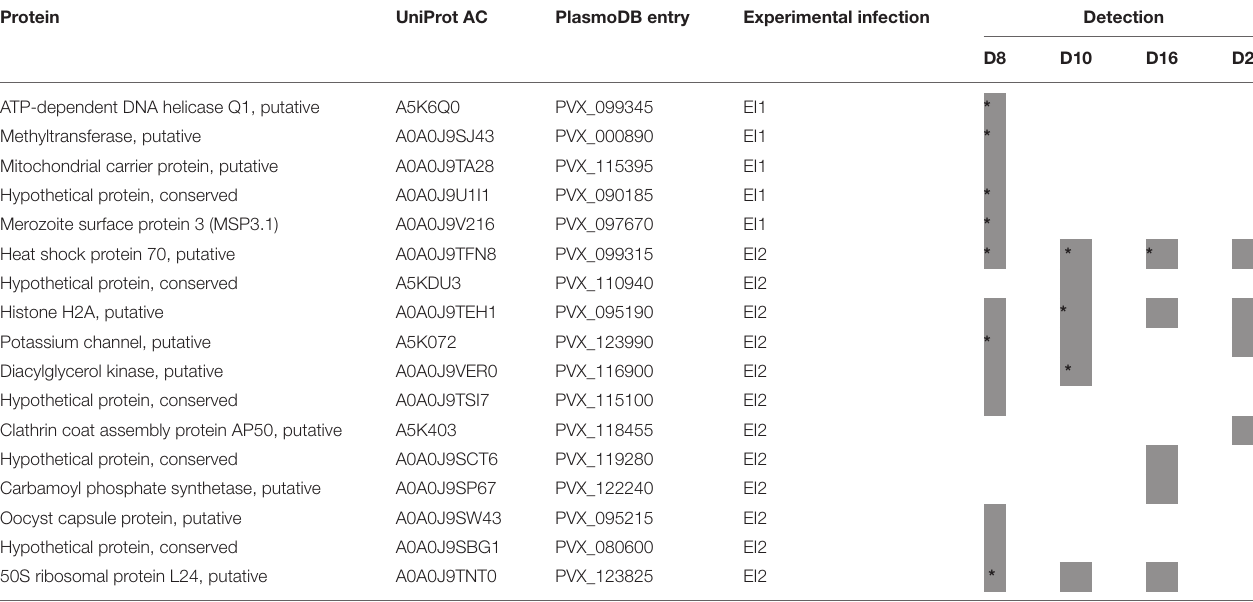
TABLE 1 | P. vivax proteins identified in plasma-derived exosomes from FRG huHep infected mice. Protein